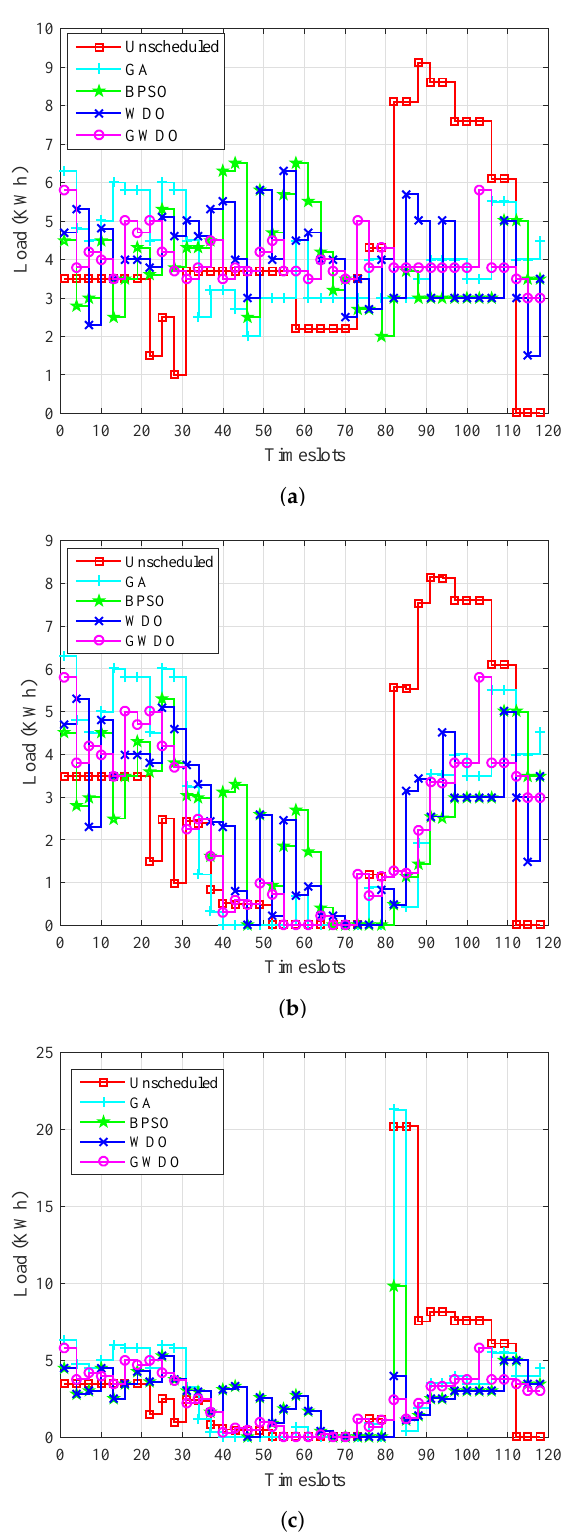
Figure 13. Energy consumption profile of users: ( a ) Without RESs and ESS; ( b ) With RESs; ( c ) With RESs and